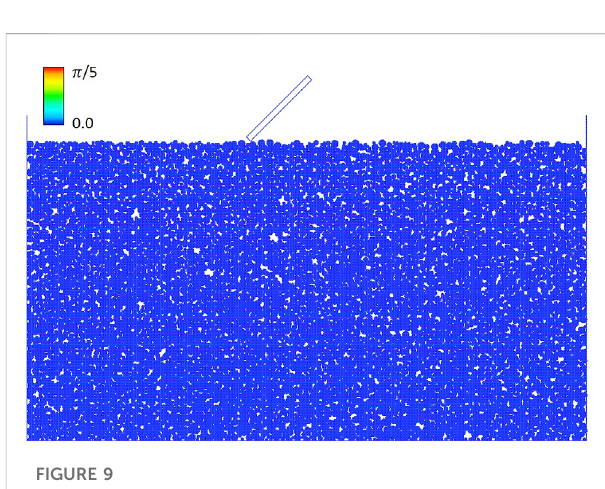
FIGURE 9 Initial con fi guration of the soil and the plate model in DEM